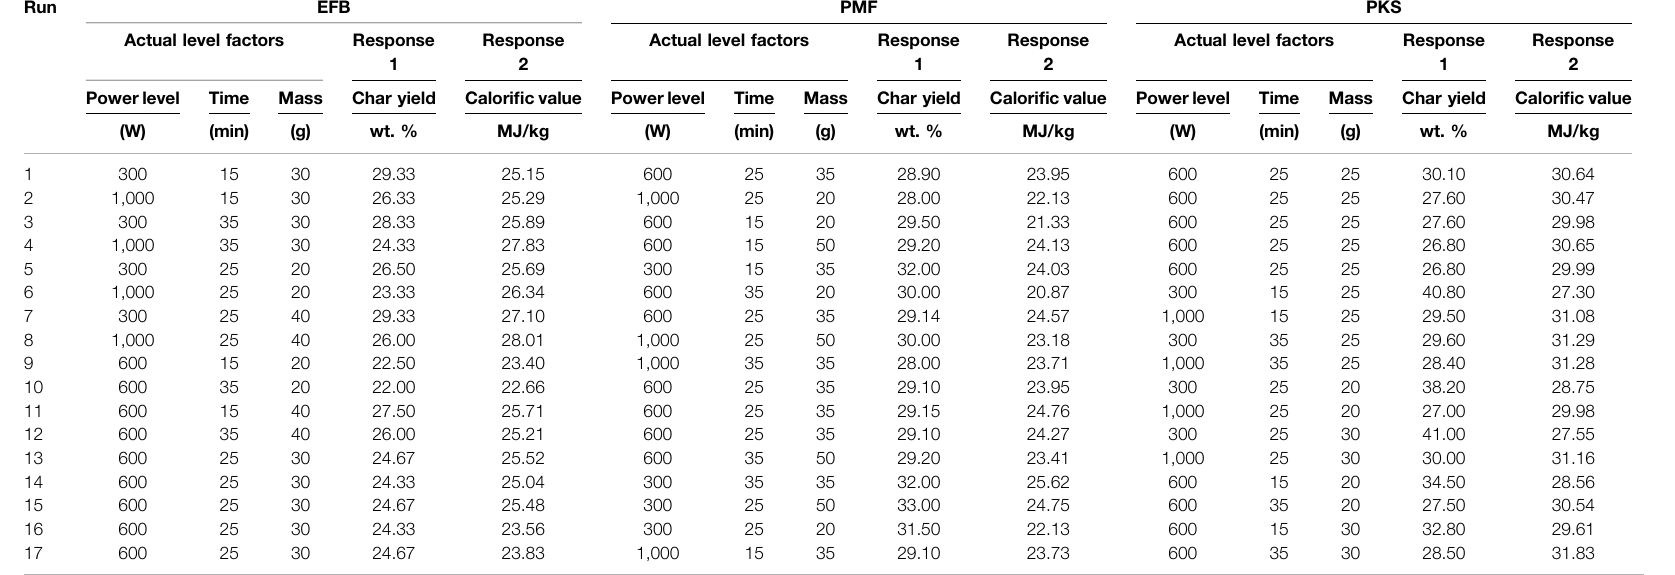
TABLE 3 | Design of experiment for microwave assisted pyrolysis